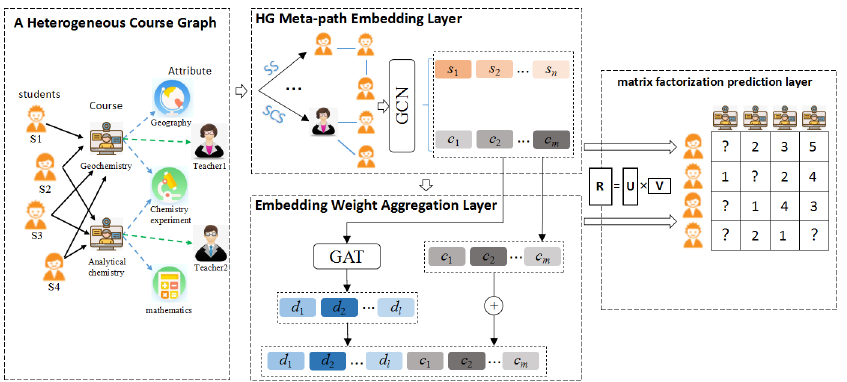
Figure 2. Framework of